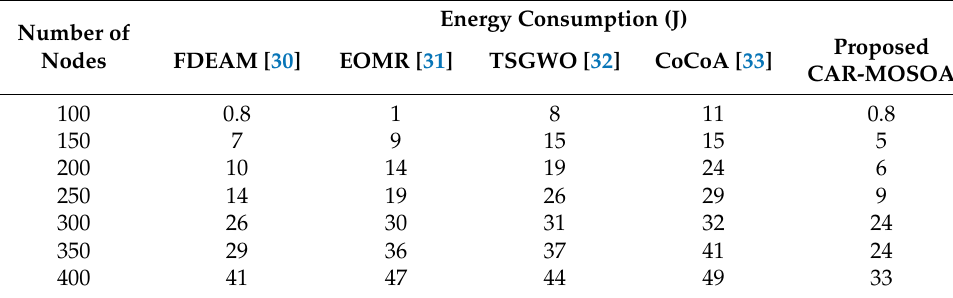
Table 2. Comparative analysis of energy